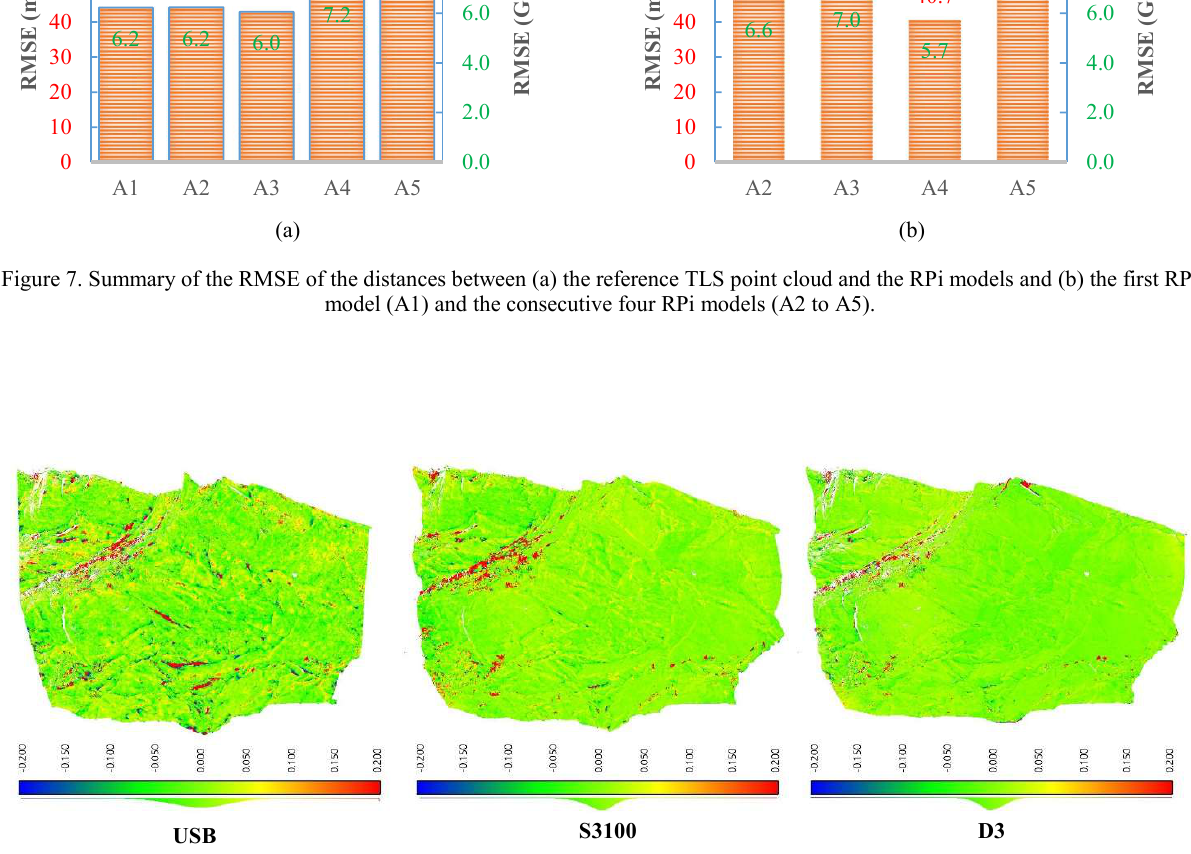
Figure 8. Example colour maps of distances between the photogrammetric models of the three sensors and the TLS point cloud for Site B at the maximum distance of 0.2 m.